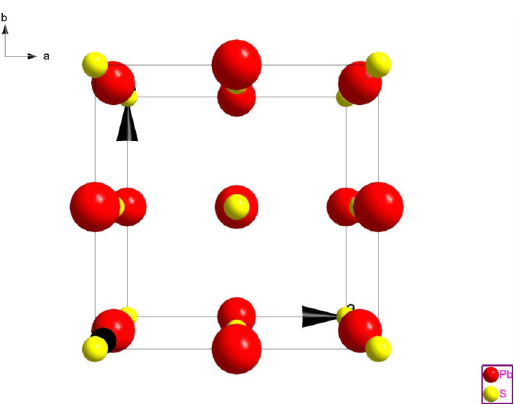
Figure 2. Structure of (PbS).